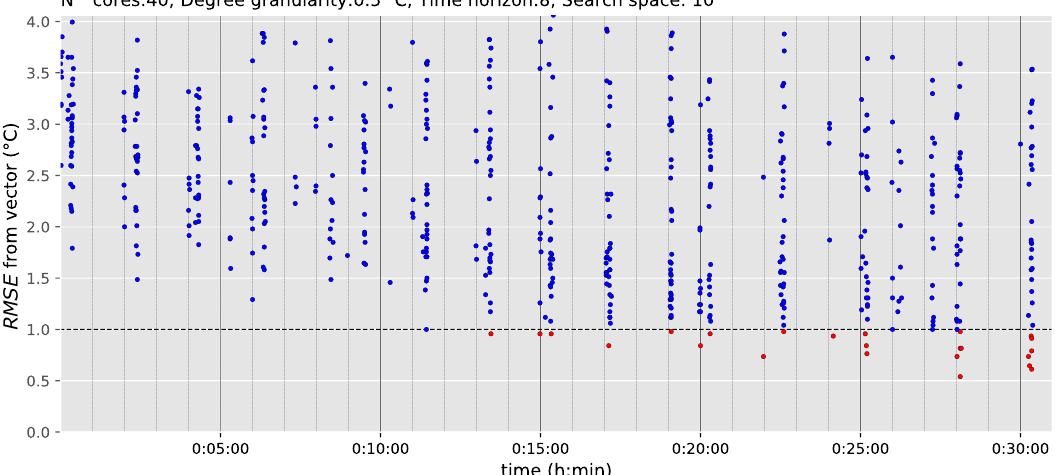
Figure 12. MPC results using one stage to obtain the MPC vector (8